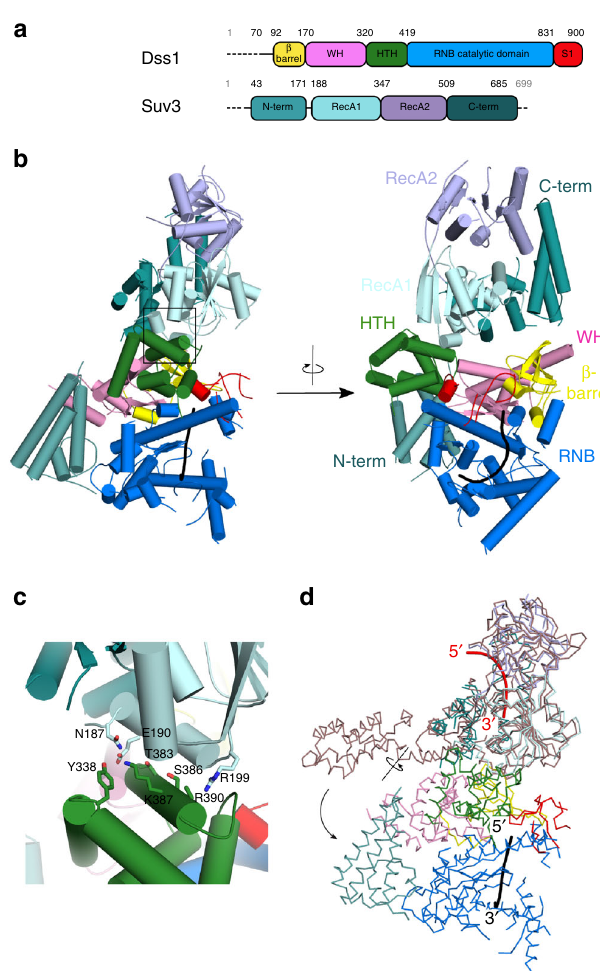
Fig. 2 Structure of the Candida glabrata mtEXO complex. a Schematic of the domain composition of Cg -Dss1 and Cg -Suv3. The dashed line corresponds to the regions deleted in the crystallized variants. b Overall structure of Cg - mtEXO complex, comprising Cg -Dss1 70 – 900 D477N and Cg -Suv3 43-685 . The domains are colored as in a . The co-crystallized RNA that is trapped in the RNB domain is shown in black. c Close-up view of the protein – protein interface that forms between the HTH domain of Cg- Dss1 and B- α -1 ′ helix of the RecA1 domain of Cg -Suv3, boxed in b . d Superposition of Cg -mtEXO and human SUV3 structure containing a 6 nt RNA chain (PDB ID: 3RC8), shown as a pink ribbon. The difference in the position of the N-terminal domain between Cg- Suv3 and Hs -SUV3 is shown with arrows. RNA chains in Hs- SUV3 and Cg- Dss1 are shown in red and black, Dss1 contacts in the crystal structure are mediated by the N- terminal domain (ND) of Cg- Suv3. Compared with human SUV3, this domain of Cg -Suv3 in the mtEXO complex has a different position relative to the rest of the structure. It is rotated by ~90° (Fig. 2d) around a hinge between residues 172 and 185 and interacts with a cleft between the WH and HTH domains and RNB domain of Cg- Dss1 (Fig. 2b). Few, mainly hydrophobic, contacts are formed between the ND of Cg- Suv3 and the RNB domain of Cg- Dss1. These interactions are mediated by Val439 and Leu443 of Cg- Dss1 and Met109 and Ile112 of Cg- Suv3. The sequence of the linker that connects the ND with the helicase core is conserved among higher eukaryotes and forms a single α -helix. However, this region is not conserved in fungi, and we did not observe its electron density in the Cg -mtEXO structure, suggesting that it was disordered. The fl exibility of this linker